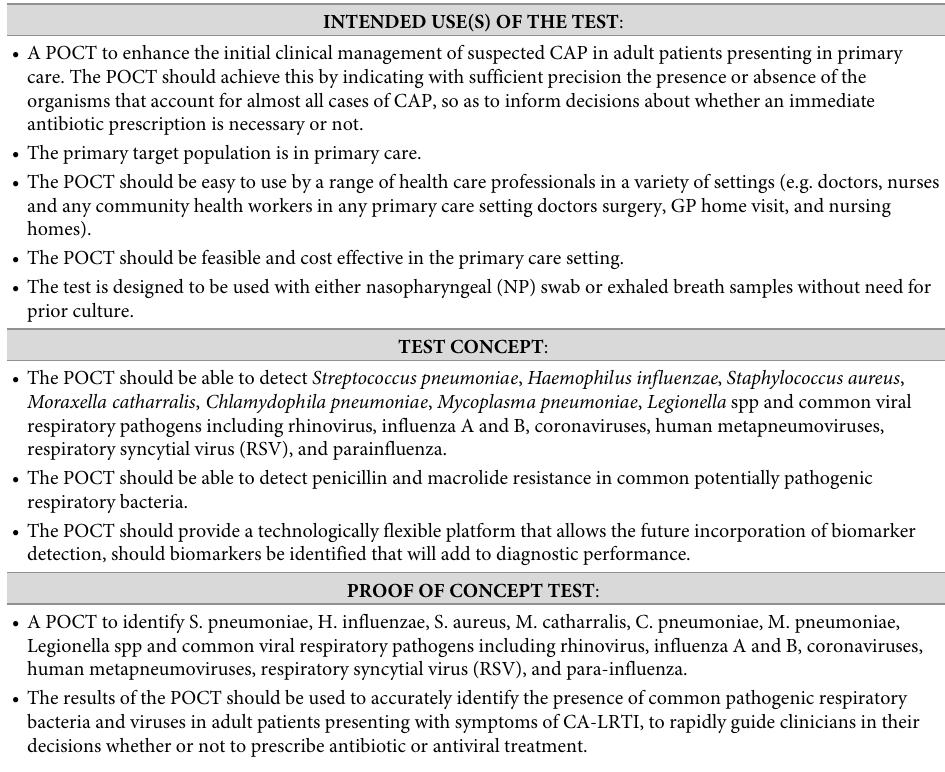
Table 5. The diagnostic product specification